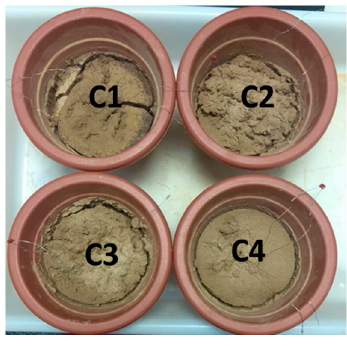
Figure 7. Soils C1 to C4.